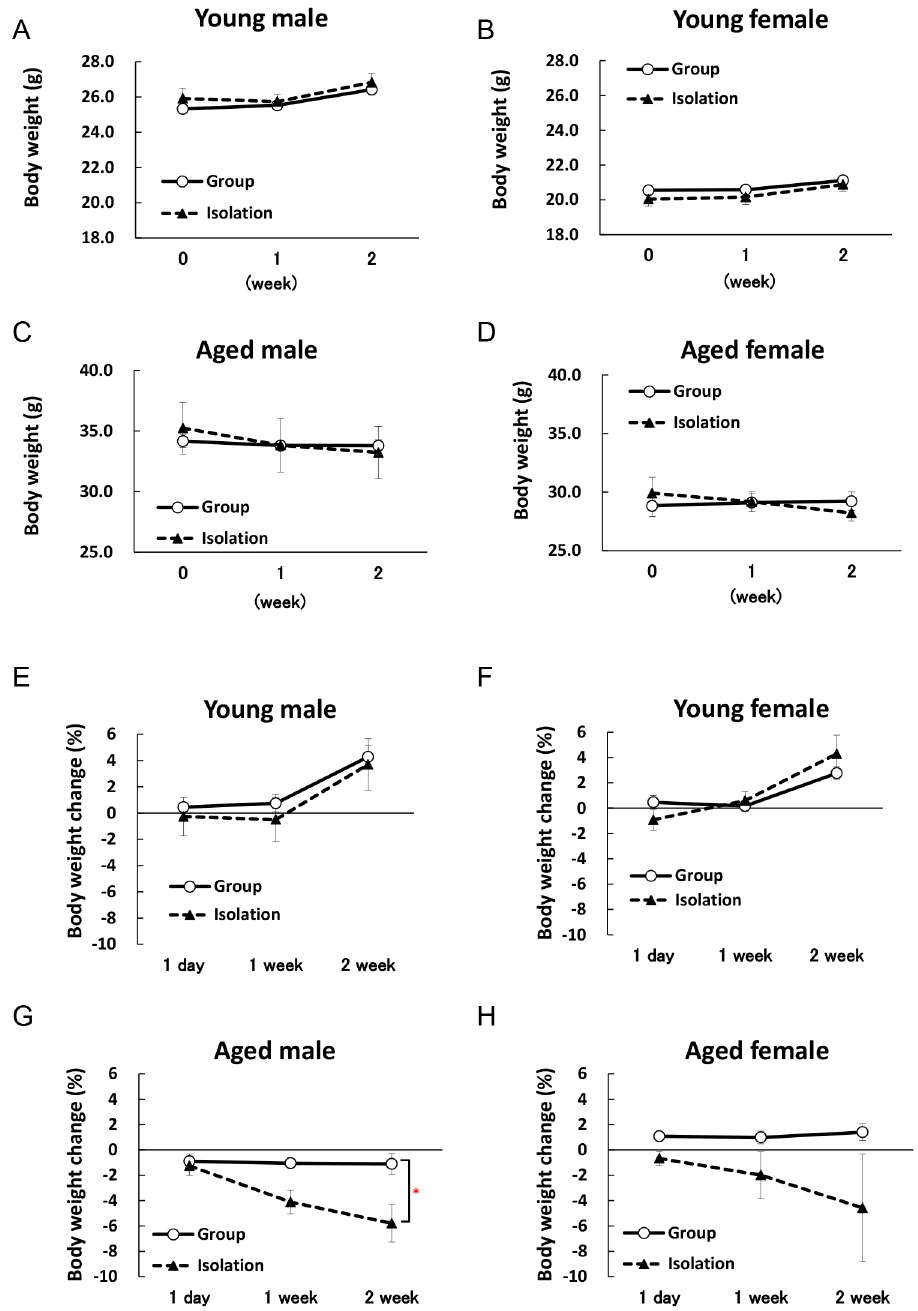
Fig 2. Body weight and changes in body weight during 2 weeks of isolation. Two-way repeated measures factorial ANOVA of body weight in all groups detected no significant changes. In the young male and female mice, two-way repeated measures factorial ANOVA of body weight changes detected no effects of isolation in males [young male: F(1, 33) = 0.4245, n.s.; young female: F(1, 36) = 0.0507, n.s.], significant effects of time in males and females [young male: F(2, 33) = 4.3506, p < 0.05; young female: F(2, 36) = 9.4196, p < 0.001], but the isolation × time interaction effects [young male: F(2, 33) = 0.0247, n.s.; young female: F(2, 36) = 0.9639, n.s.] were not significant. In aged mice, there were significant effects of isolation in males [aged male: F(1, 21) = 7.9029, p < 0.05; aged female: F(1, 24) = 2.0955, n.s.], time in males [aged male: F(2, 21) = 3.9764, p < 0.05; aged female: F(2, 24) = 0.4656, n.s.], but the isolation × time interaction effects [aged male: F(2, 21) = 1.7366, n.s.; aged female: F(2, 24) = 0.2593, n.s.] were not significant. Body weights of young male mice (A), young female mice (B), aged male mice (C), and aged female mice (D) are